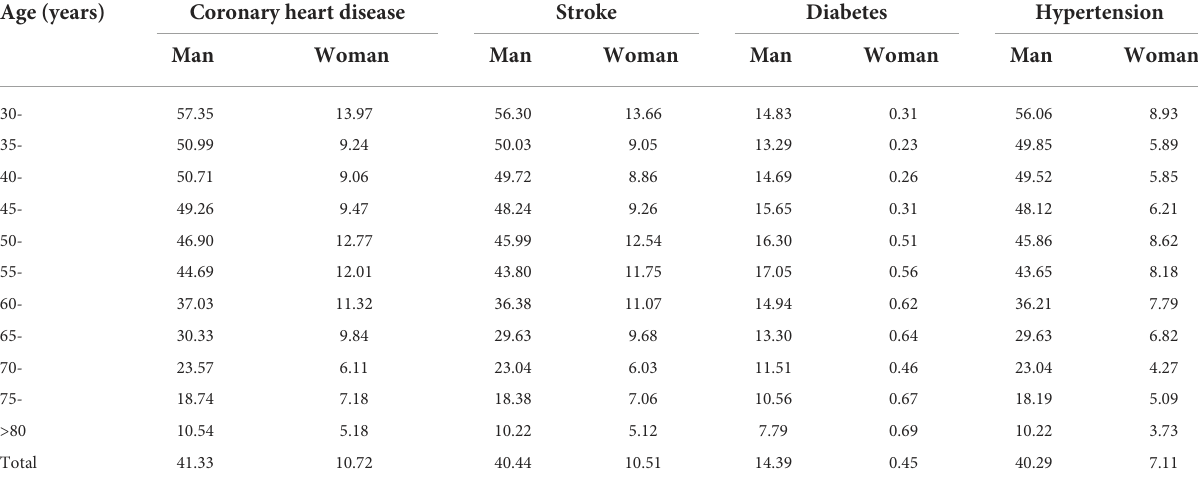
TABLE 3 Attribution scores of smoking by sex and age group in the Shanxi Province (%).